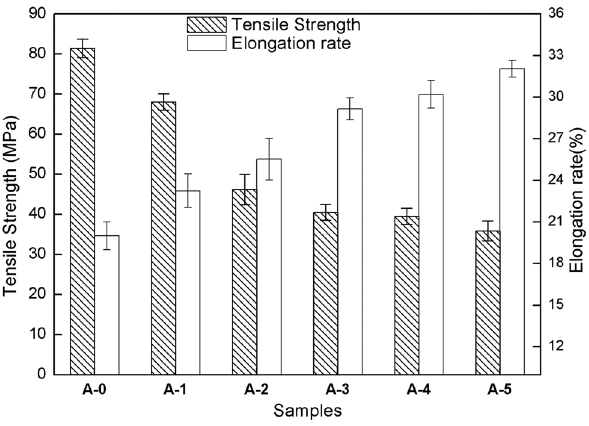
Figure 5: Tensile strength and elongation ratio of composites.